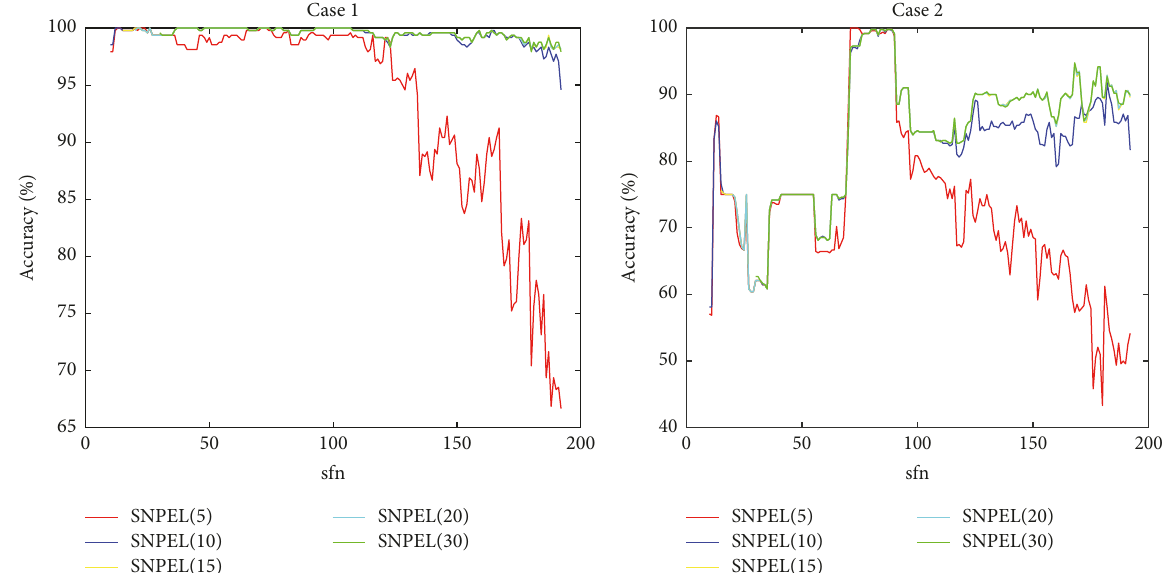
Figure 19: The diagnosis results obtained by OFS-FSASD-SNPEL-SVM using WPT with different number of dimension sizes for SNPEL. The SNPEL (5) represents that the number of dimension sizes is 5.